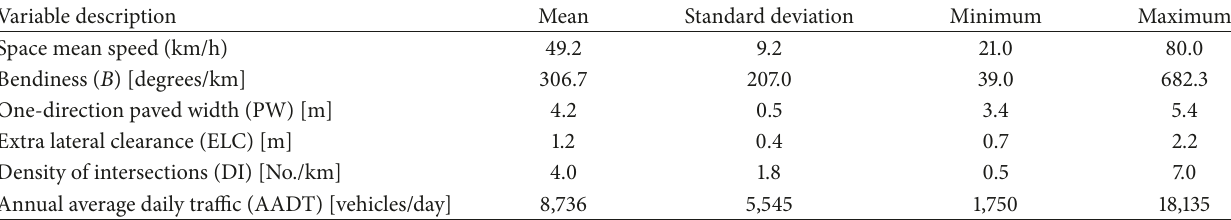
Table 1: General data on calibration